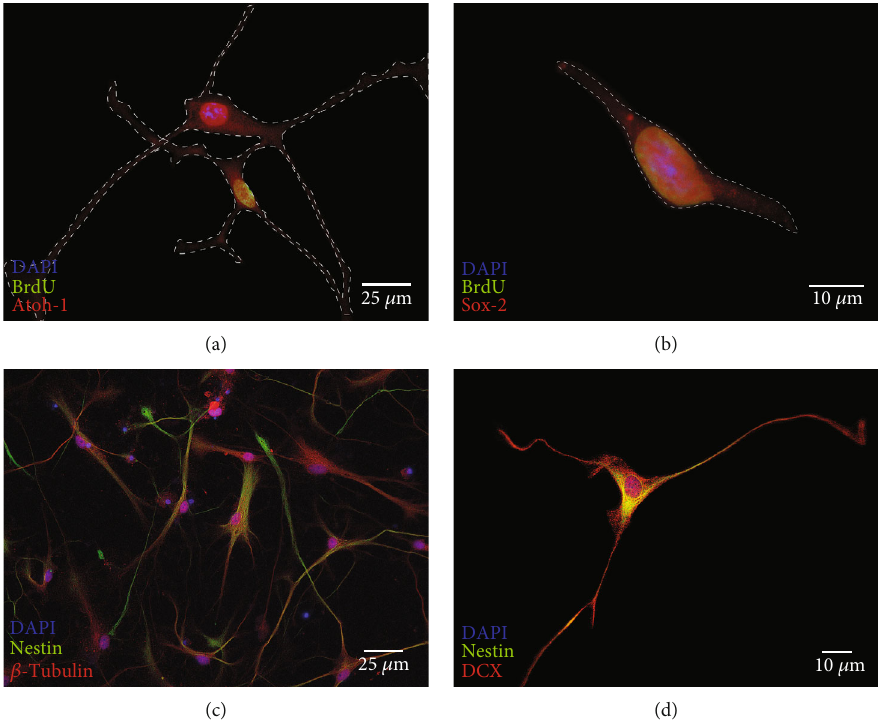
Figure 6: Dissociated cells of neurospheres were plated on glass coverslips and incubated for 24h in NSC medium. (a, b) BrdU (10 μ M) was added to the cell medium. After fi xation, immunocytological staining of the BrdU incorporation (green) of single cells and the progenitor cell markers Atoh1 and Sox-2 (red) was carried out. These cells showed positive labelling for the transcription factors Atoh1 and Sox-2, which play a crucial role in the auditory pathway development. (For a better illustration of the somata and cell branches, the contours were drawn with dashed lines.) (c) After incubation in NSC medium for 24h, cells were fi xed. In the network, neural progenitor cells were identi fi ed by the marker Nestin (green). Nestin-negative cells were stained by β -tubulin and showed the morphology of di ff erentiating bipolar neurons. (d) Neural stem cells of the single-cell culture showed a colocalization of the markers Nestin (green) and DCX (red). Nuclei were stained with DAPI